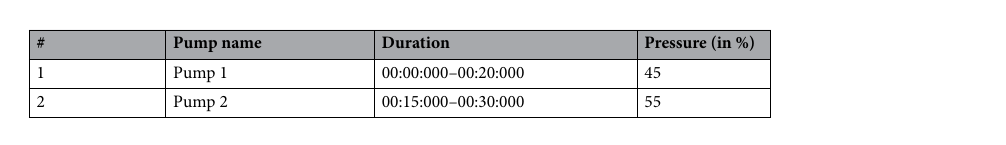
Table 2. Program sequence for demonstrating active control handled by the system (experiment #2).